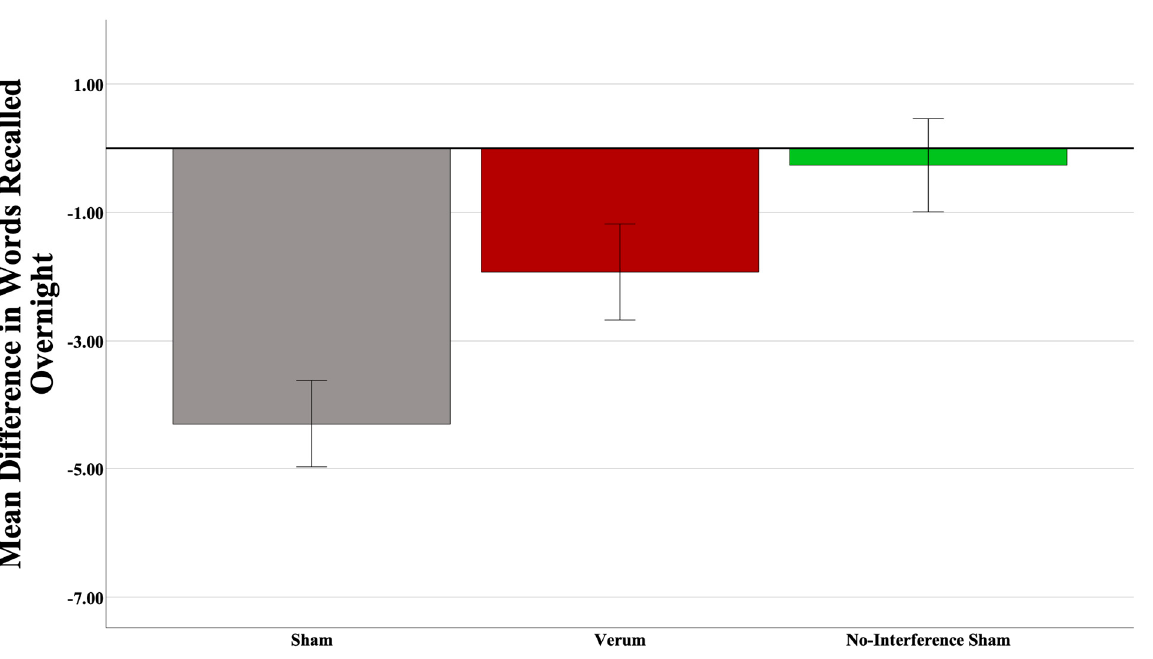
Figure 5. Interference is reduced with CL-tACS. A significant difference between the current experiment and PAT sham groups was observed, where the PAT sham group recalled significantly more words than did the current experiment sham group ( p = 0.000613). There was no significant difference between the verum and PAT sham groups, which suggests CL-tACS does provide some protection from retroactive interference. Error bars = +/ − 1 SEM.